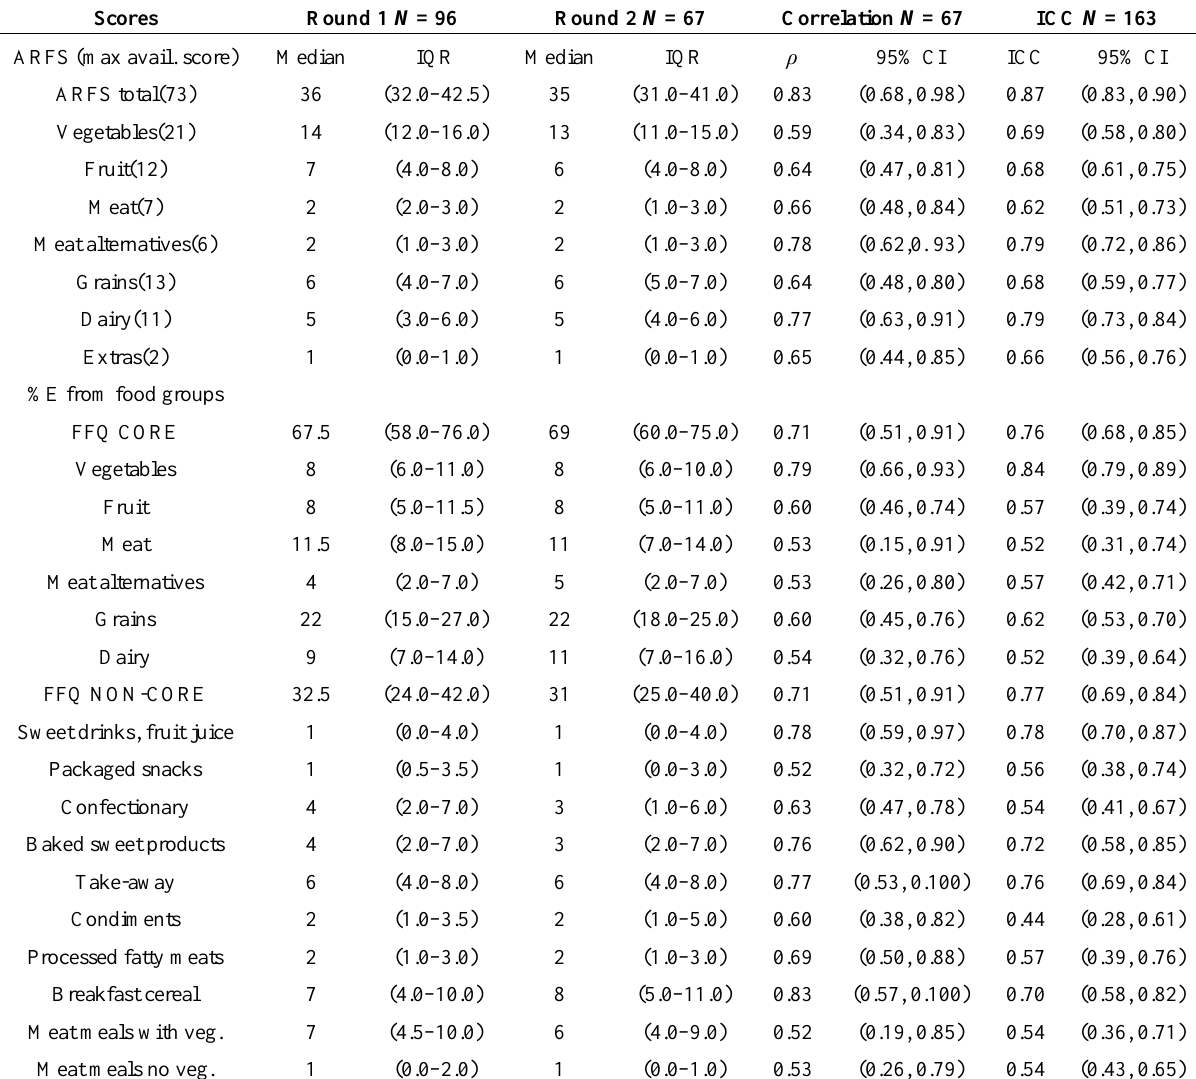
Table 4. Reproducibility of The Australian Recommended Food Score (ARFS) components and the AES FFQ percentage of energy (%E) from core and non-core food groups: Median, interquartile range (IQR) and correlation between